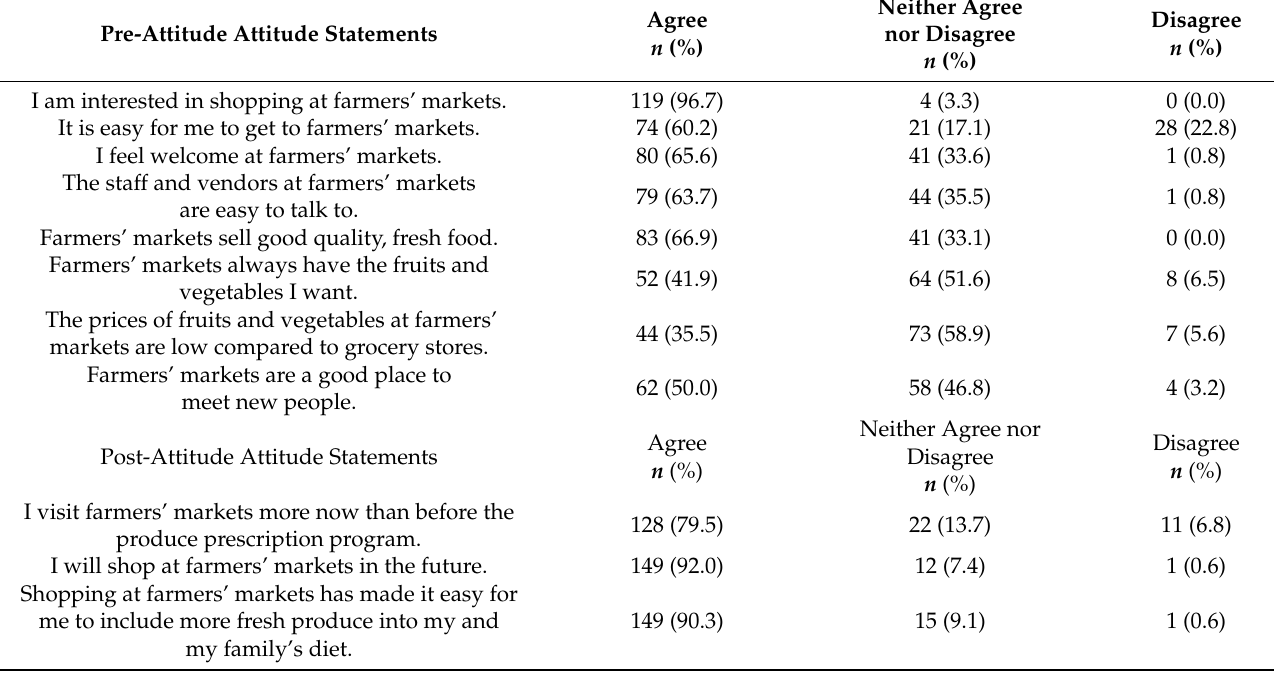
Table 3. Pre-intervention ( n = 125). and post-intervention ( n = 165) attitudes about farmers’ markets ( n = 125).